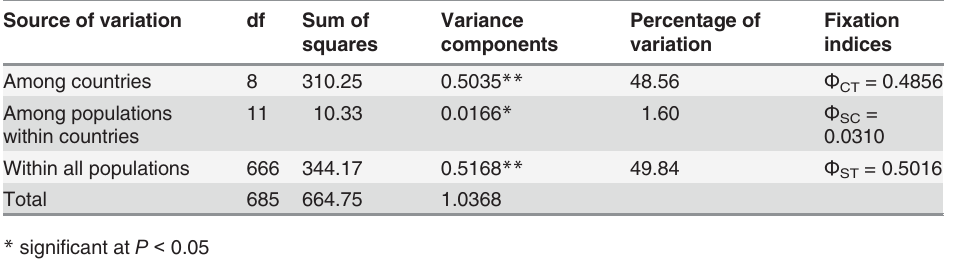
Table 6. Result of AMOVA analysis of Maruca vitrata populations from nine countries in South- and Southeast Asia as well as sub-Saharan Africa, based on coxI sequence data. Source of variation df Sum of Variance squares components